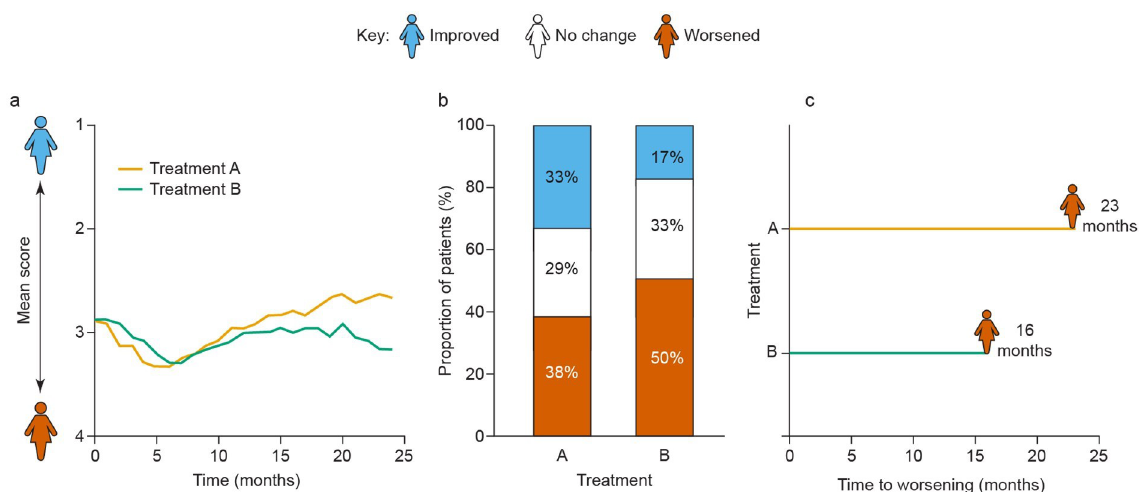
Fig 2. Endpoint preferences: Hypothetical trial data on physical functioning. The three endpoint scenarios depicting outcomes for two different groups of patients treated with hypothetical drugs A and B: (a) time-dependence of a mean score for physical function; (b) percentage of patients experiencing improvement, no change, or worsening in physical functioning over the course of treatment; ( c) median time to worsening of physical functioning.